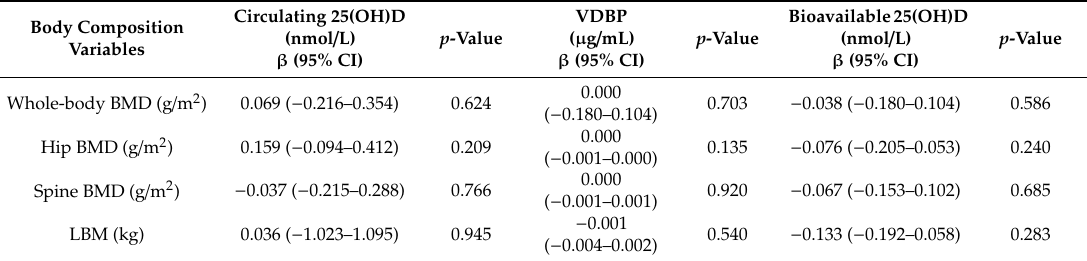
Table 2. Parameter estimates ( β 95% CI) of association of vitamin D parameters with independent body composition variables (whole body, hip, and spine BMD, and LBM) after adjusting for sport and skin